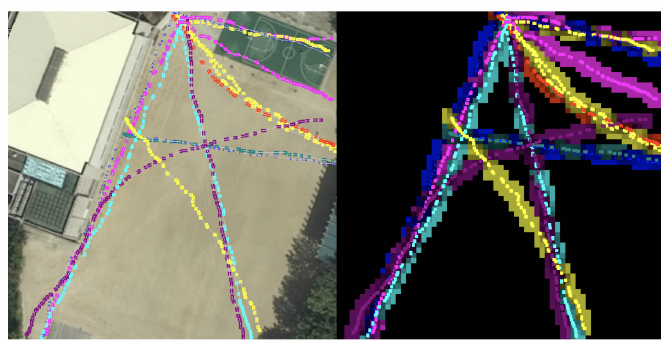
Figure 3. Influence map (IM) from the trajectory data.